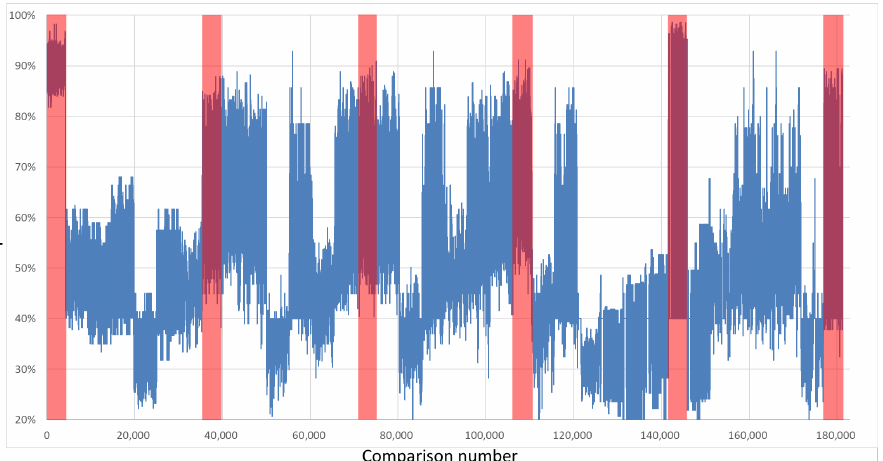
Figure 10. Results of the comparison of each key pair for all boards in a set—Intel MAX10 x 4 + x 3 + 1.